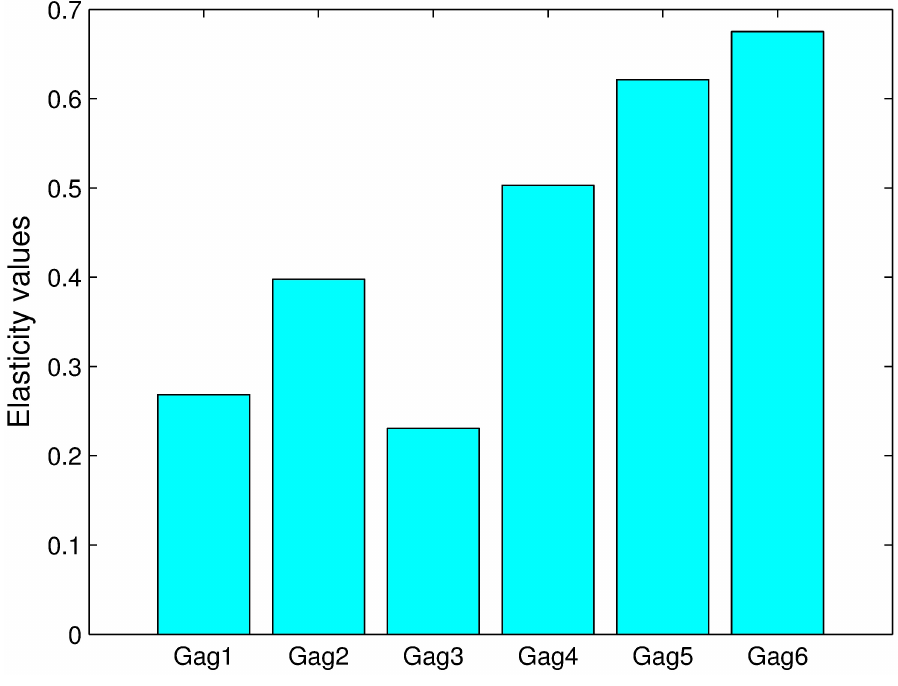
Fig 9. The global elasticity analysis of the